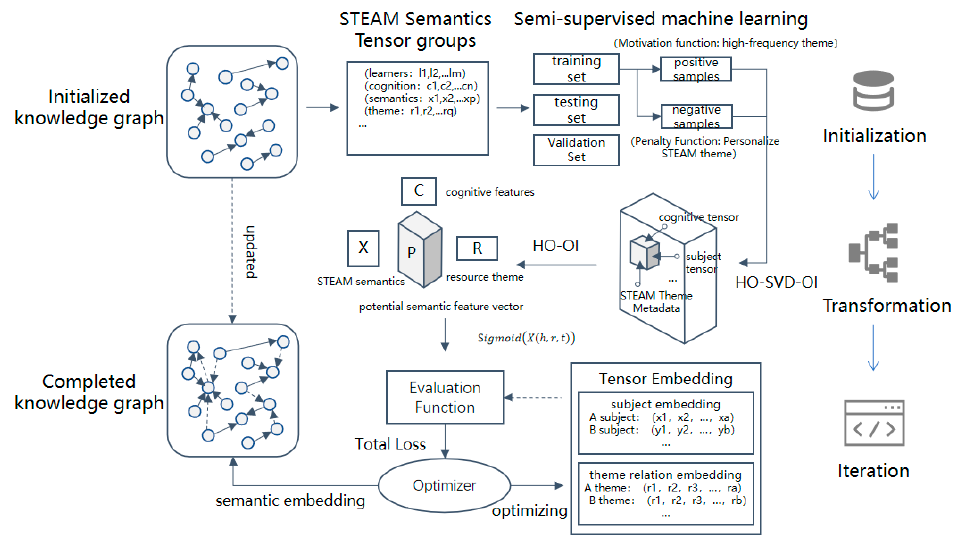
Figure 2. Dynamic completion model of STEAM knowledge graph based on tensor decomposition.